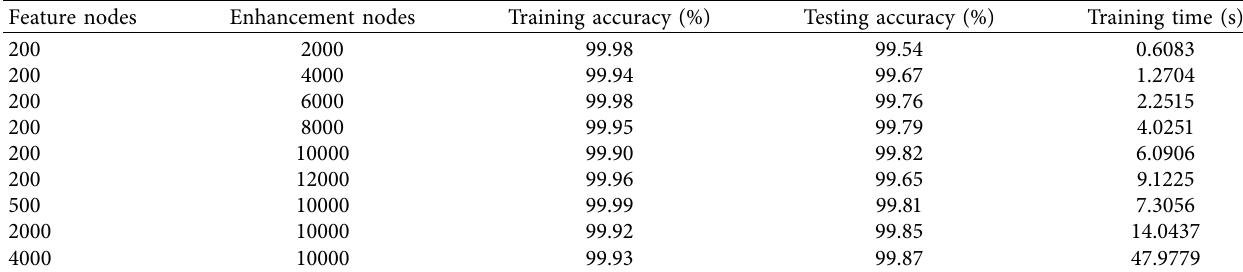
Table 3: The result of adding three features to